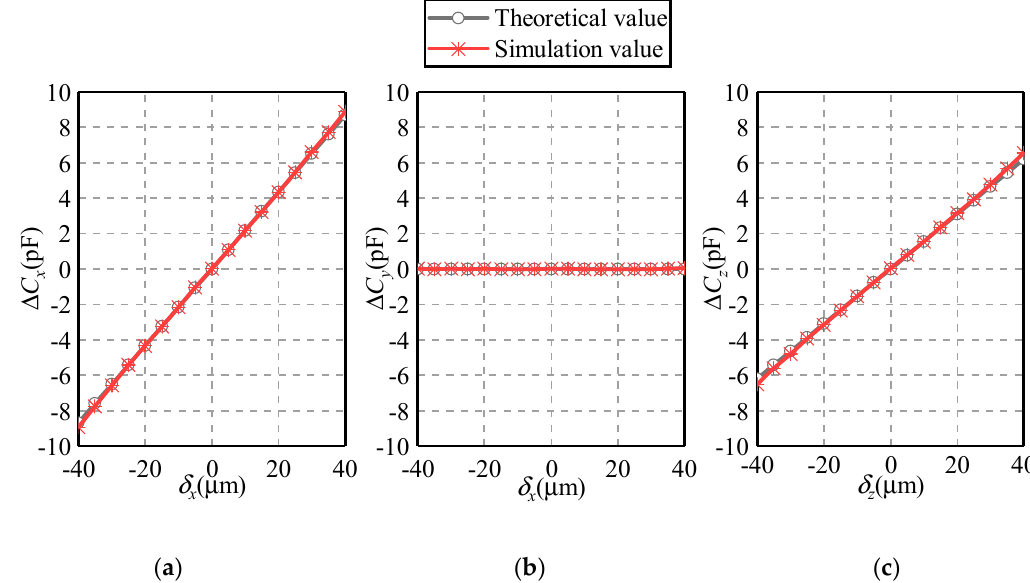
Figure 13. Dependence of the differential capacitance on the eccentric displacement along the X = Z direction ( a ) ∆ C x , ( b ) ∆ C y and ( c ) ∆ C z .